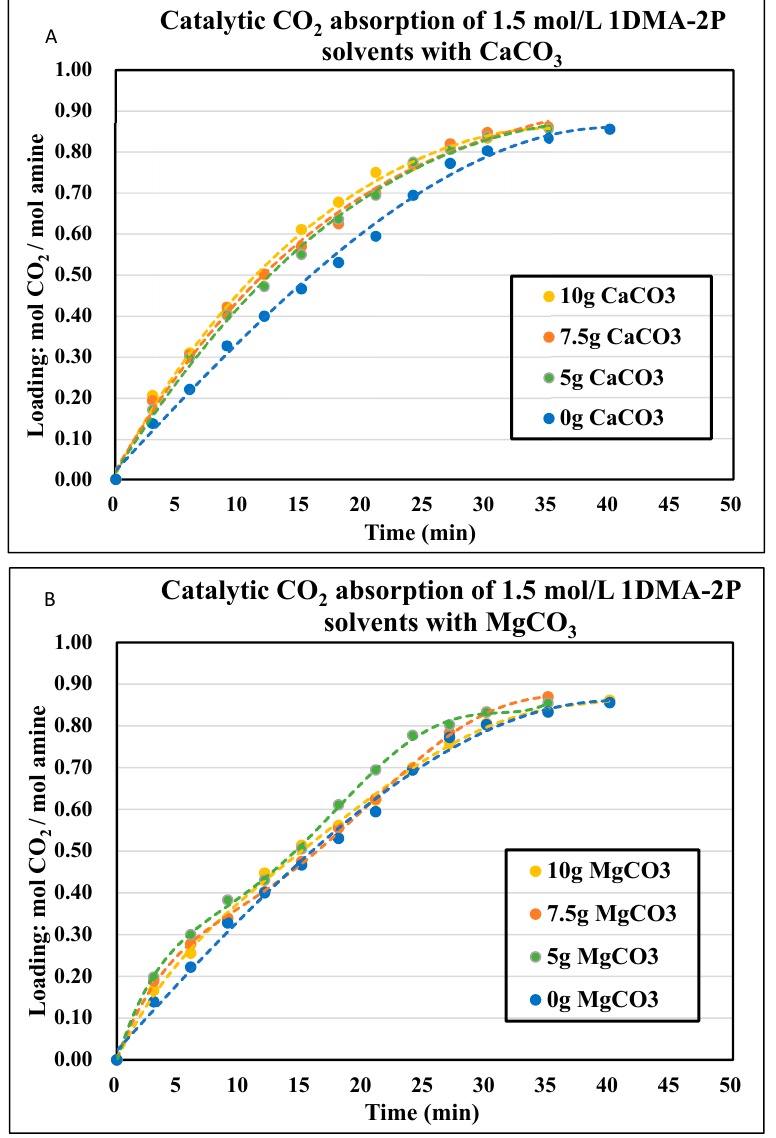
Figure 6. Catalytic CO 2 absorption curves of 1.5 mol/L 1DMA-2P solvents at 293 K and 1 atm. ( A ) CaCO 3 0–10 g. ( B ) MgCO 3 0–10 g.